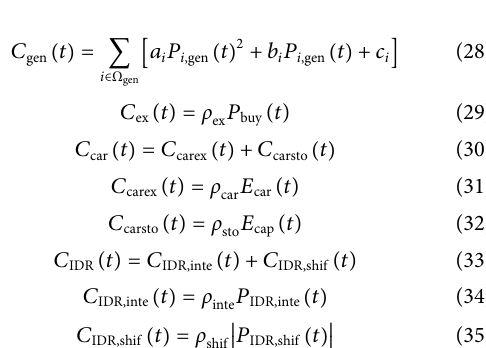
FIGURE 1 The revised IEEE-33 bus distribution